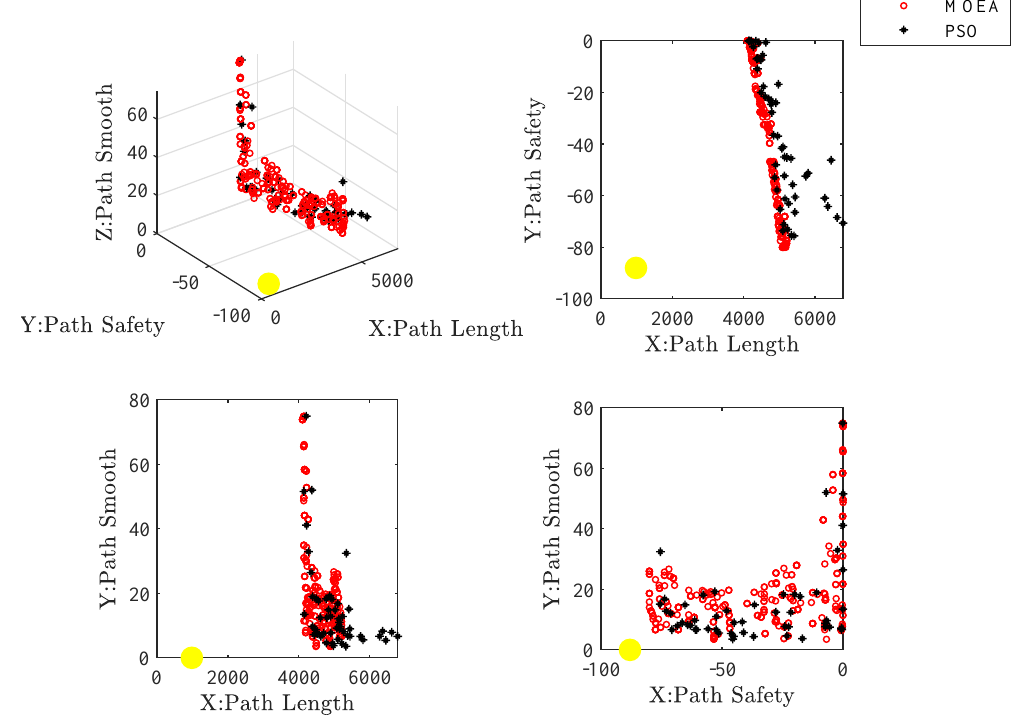
Figure 12. Approximate Pareto fronts for Figure 8D: MOEA vs.